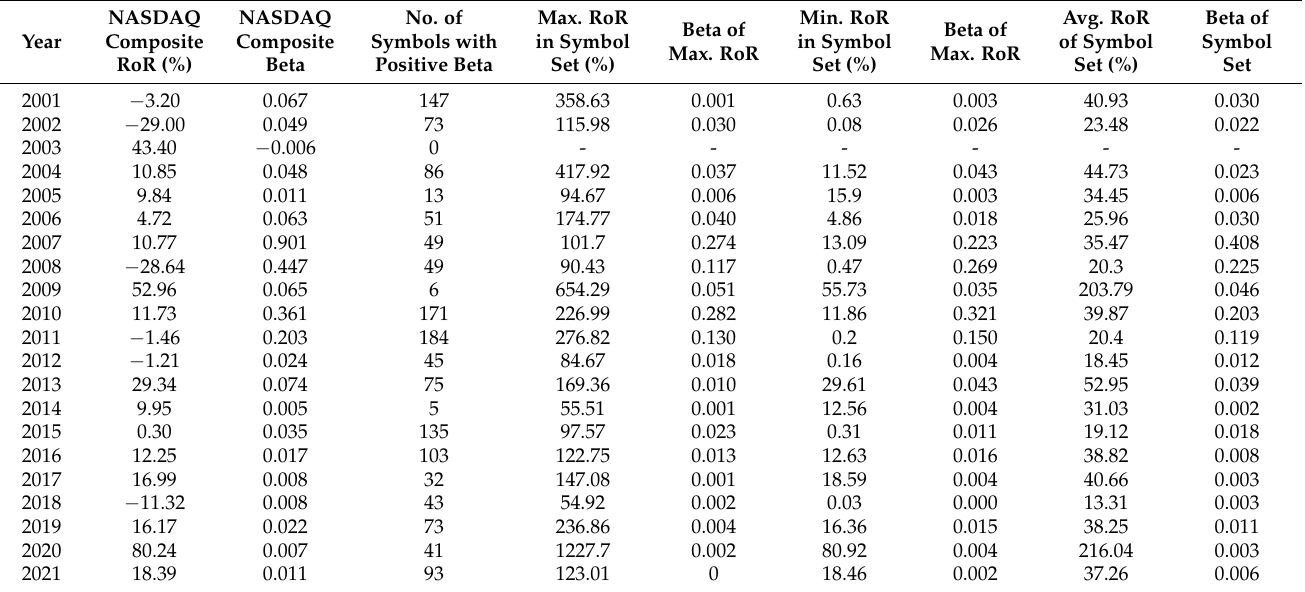
Table 4. Sets of NASDAQ symbols, selected annually, based on the rate of return (RoR) of the NASDAQ Composite index and its beta relative to the CSIE of the market as a whole. Only sets of stocks with positive beta relative to the market CSIE